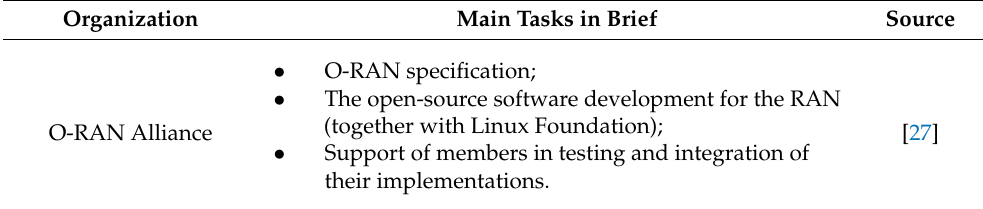
Table 1. Main organizations related to Open RAN